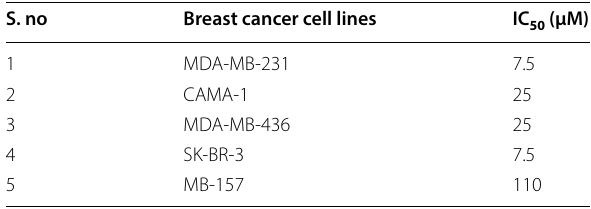
Table 1 Effects of Mukonal on the viability of breast cancer cells as depicted by MTT assay and presented as IC